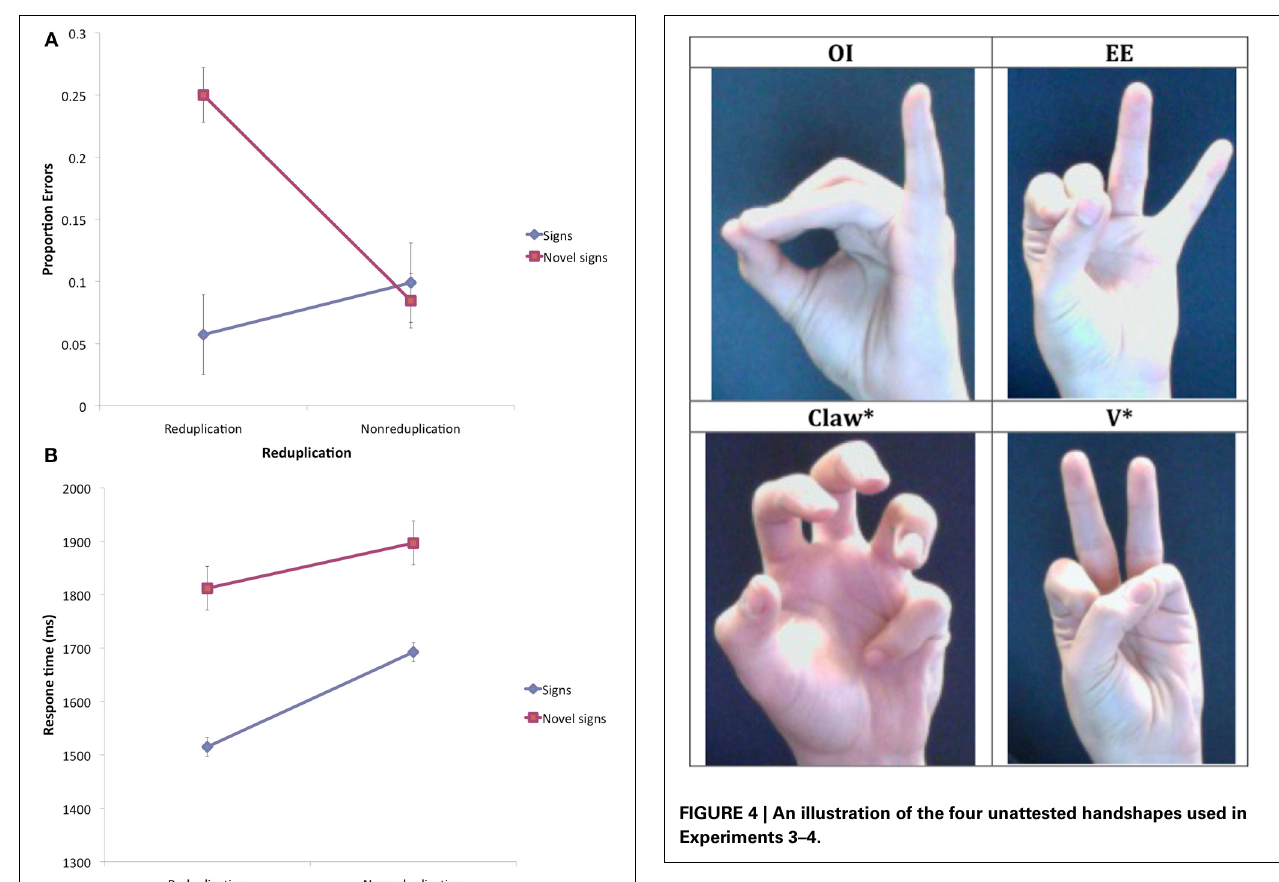
four handshapes are all sign-like, and two of them—the